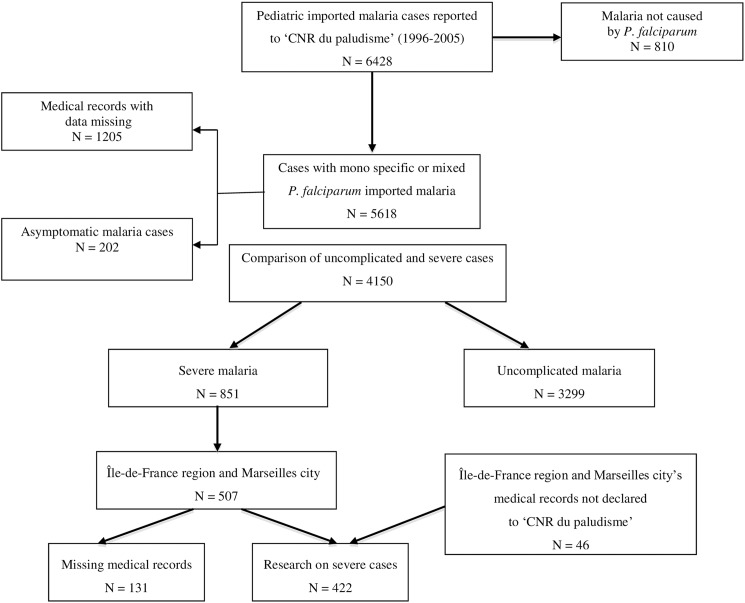
Flow chart of the study: First, comparison between severe and uncomplicated cases registered in the national pediatric database of CNR du paludisme, then research on severe cases in the medical records of hospitals from Region Île-de-France and the city of Marseilles having declared more than 5 severe malaria cases during the period 1996–2005.